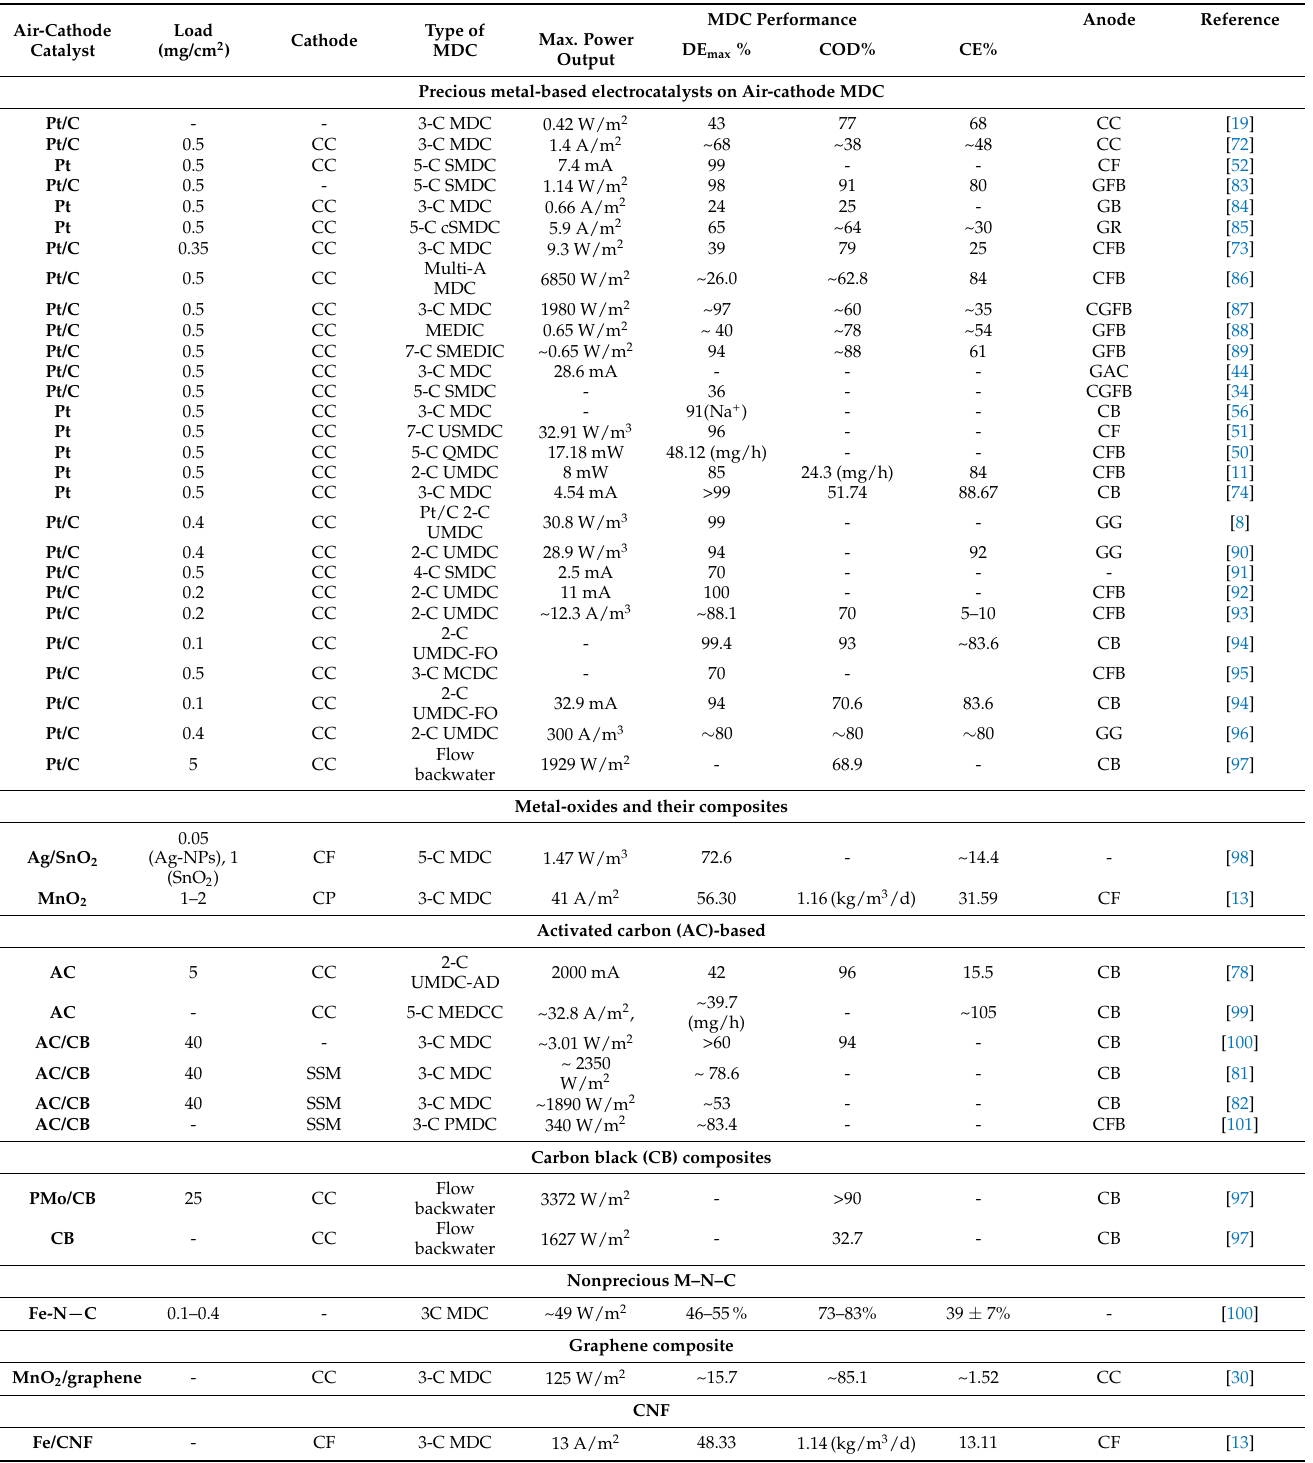
Table 2. Electrocatalyst applied on air-cathode MDC